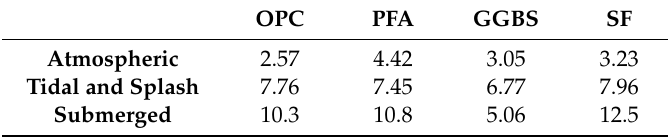
(%, relative to binder). s , cl OPC PFA GGBS